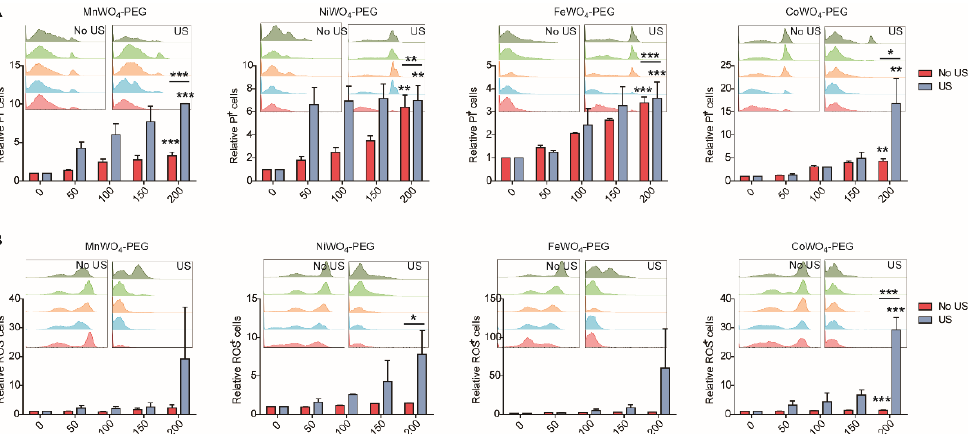
Figure 4. MWO 4 -PEG NPs mediated cytotoxicity to OCI-LY19 cells. ( A ) The relative apoptosis rate of human OCI-LY19 cells treated by increasing concentration (0, 50, 100, 150, 200 μ g/mL) of four MWO 4 -PEG NPs with or without US irradiation. The propidium iodide (PI) was used to stain the NPs treated OCI-LY19 cells to indicate apoptosis cells. The percentage of PI + cells after administration of MWO 4 -PEG NPs with or without US activation was detected by flow cytometry. ( B ) The percentage of ROS generation by OCI-LY19 DLBCL cells after incubation with different concentrations (0, 50, 100, 150, 200 μ g/mL) of MWO 4 -PEG NPs in the presence or absence of US. The upper showed the primary data obtained from flow cytometry, and the lower showed the statistical chart of relative PI + or ROS + cells. The data shown are representative of 3 independent experiments. Data are represented as mean ± SD. *, ** and *** represent p < 0.05, p < 0.01 and p < 0.001, respectively.